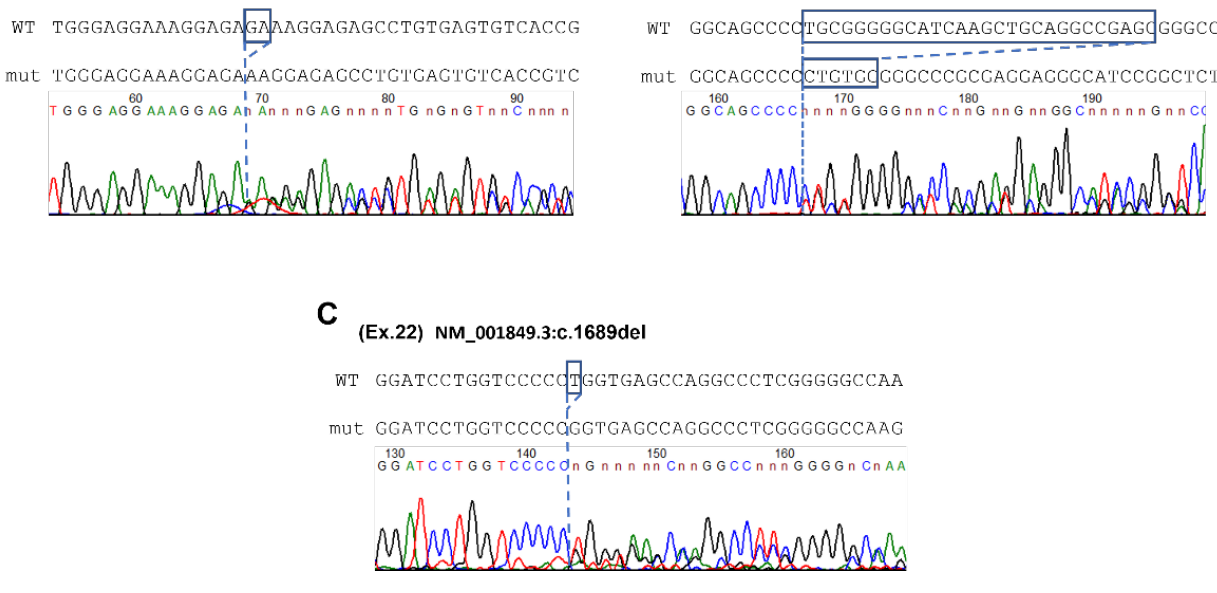
Figure 2. Sanger sequencing of c.1659_1660del variant (spotty blue line indicates deletion site) ( A ), c.508_535delinsCTGTGG variant (spotty blue line indicates deletion sites) ( B ), and c.1689del variant (spotty blue line indicates deletion site) ( C ).